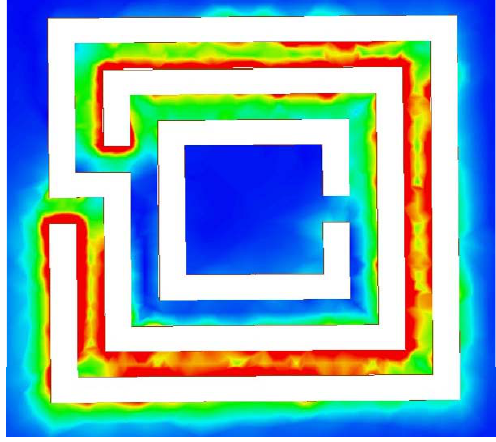
Figure 15. Simulated current distribution on a new CSRR at a resonance frequency of around 3 . 781 GHz. The red color indicates the highest current